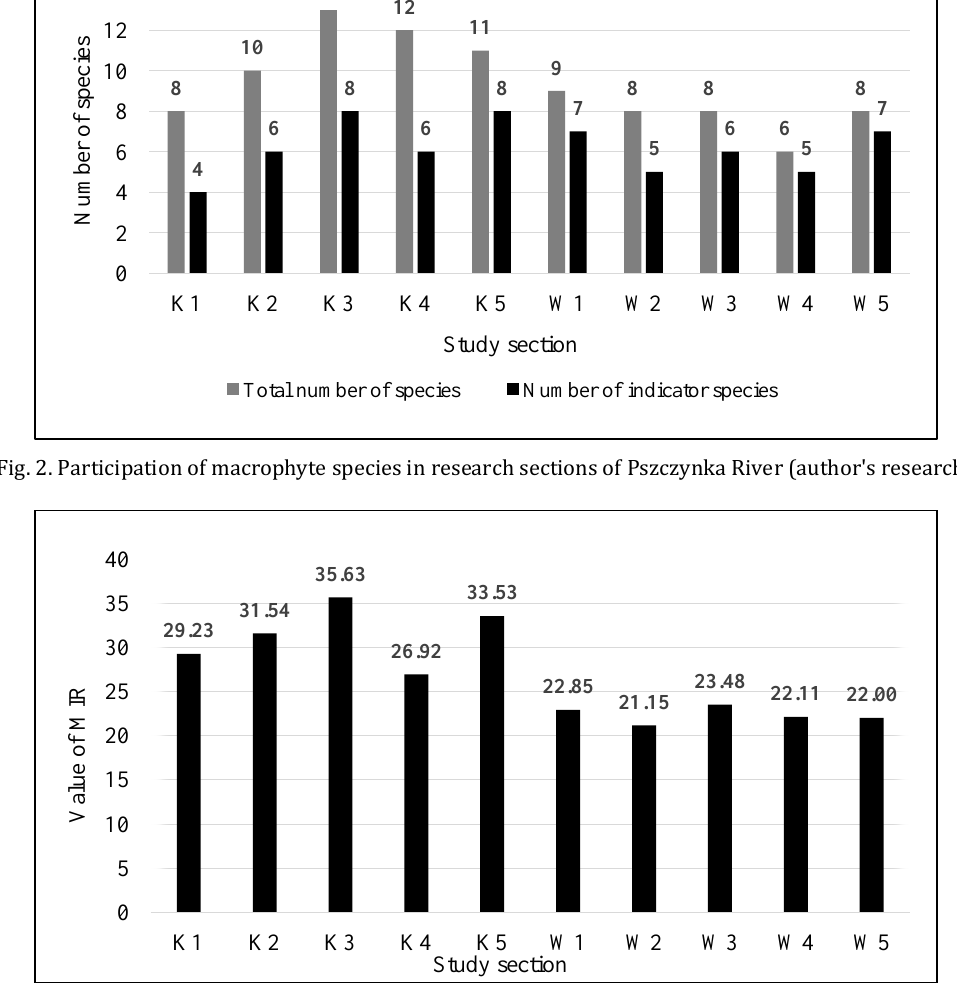
Fig. 3. Macrophyte River Index value in study section of Pszczynka River (author's research)